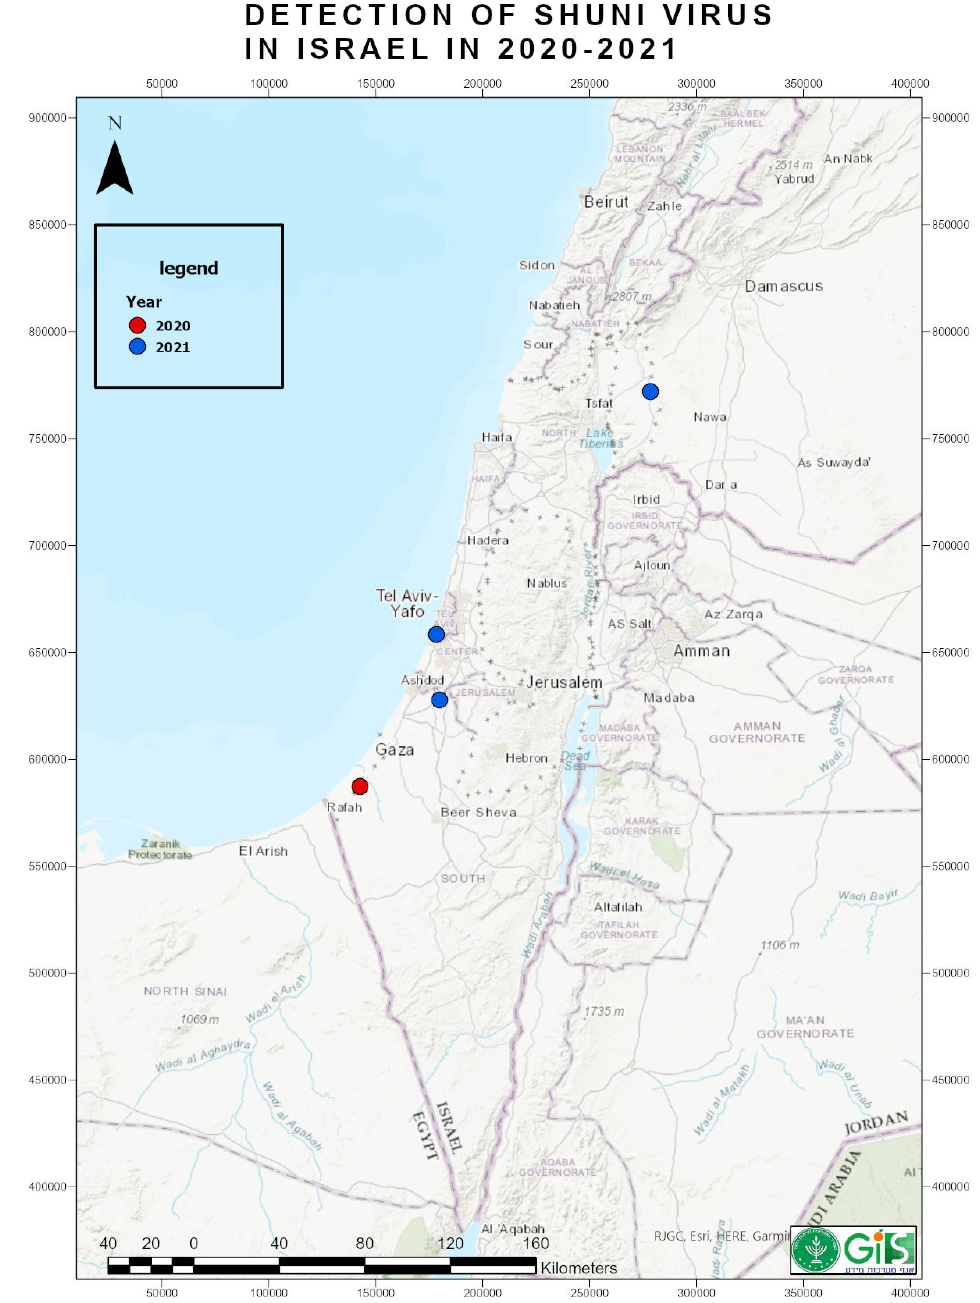
Figure 1. Map of geographic places where Shuni virus infections of domestic ruminants were registered,